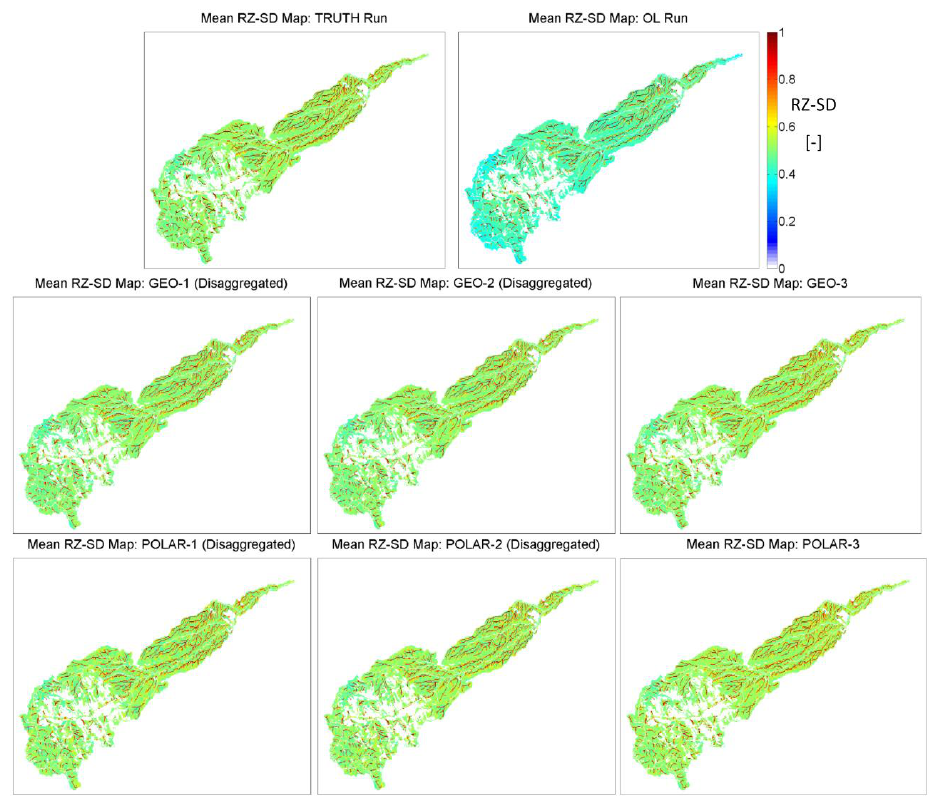
Figure 6. Comparison between the mean RZ-SD value of GEO SAR-like SM products (second row: GEO-1 Disaggregated, GEO-2 Disaggregated and GEO-3) and the mean RZ-SD value of POLAR SAR-like SM products (third row: POLAR-1 Disaggregated, POLAR-2 Disaggregated and POLAR-3), as opposed to the average of the TRUTH and the OL runs (first row).